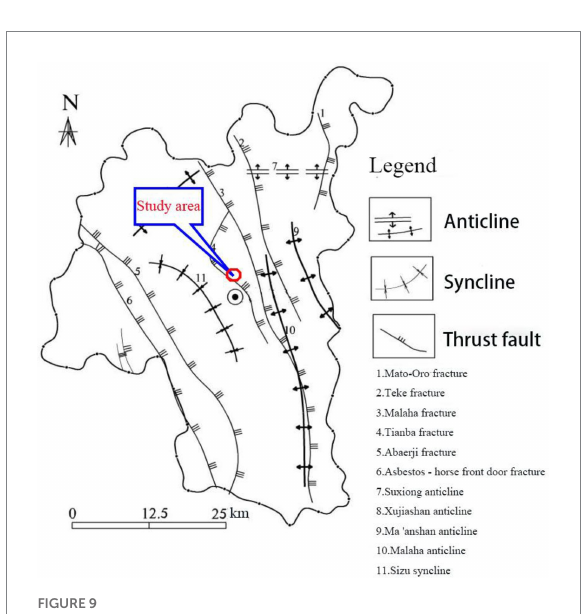
FIGURE 9 Tectonic movement map of Ganluo